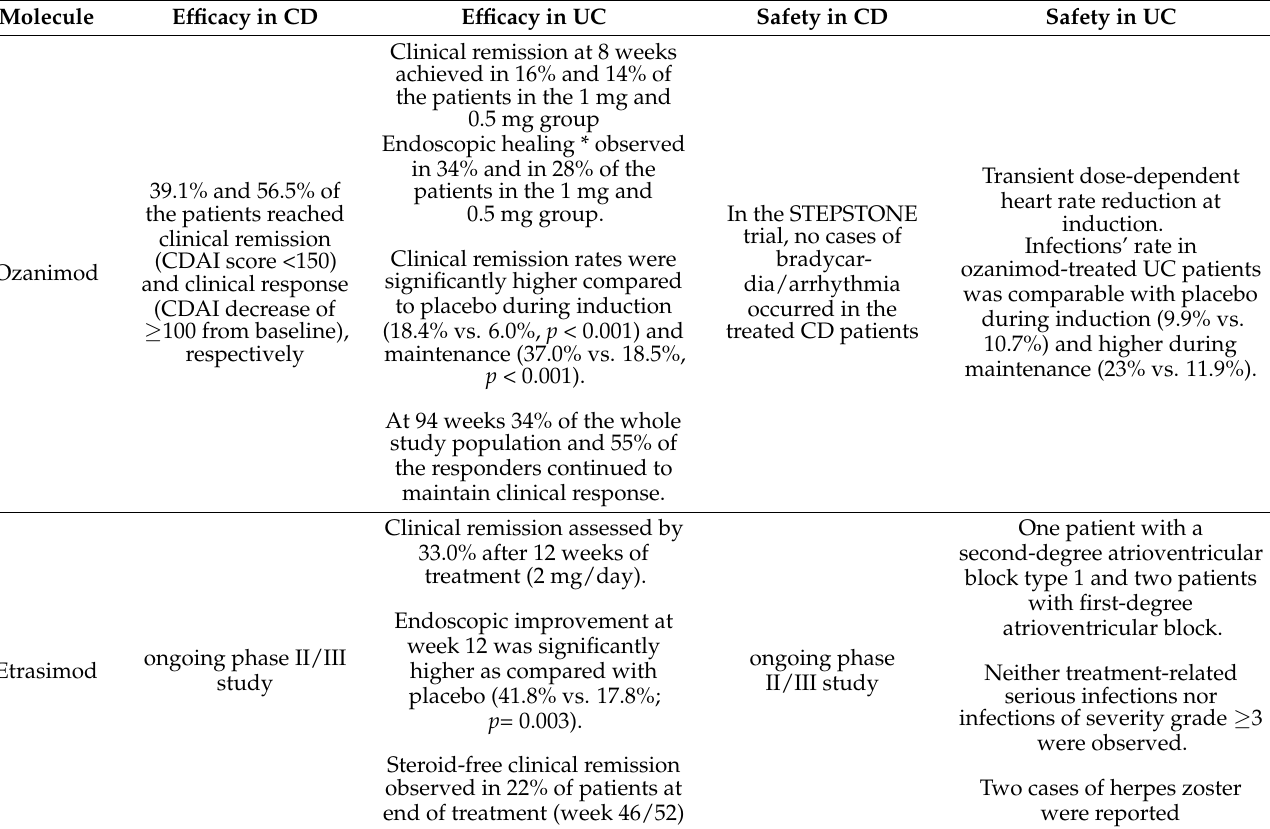
Table 2. Efficacy and safety of ozanimod and etrasimod in IBD. Molecule Efficacy in